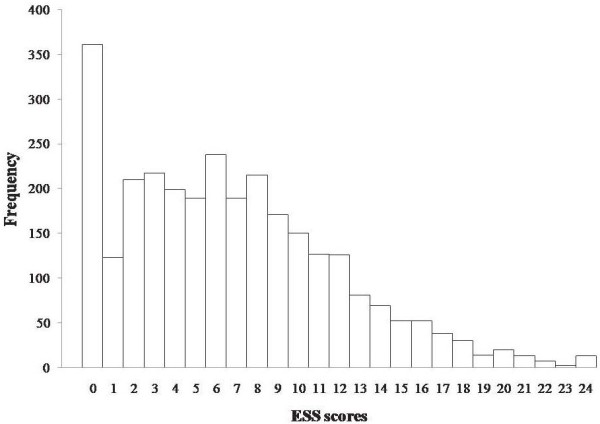
Distribution of ESS scores in the sample.